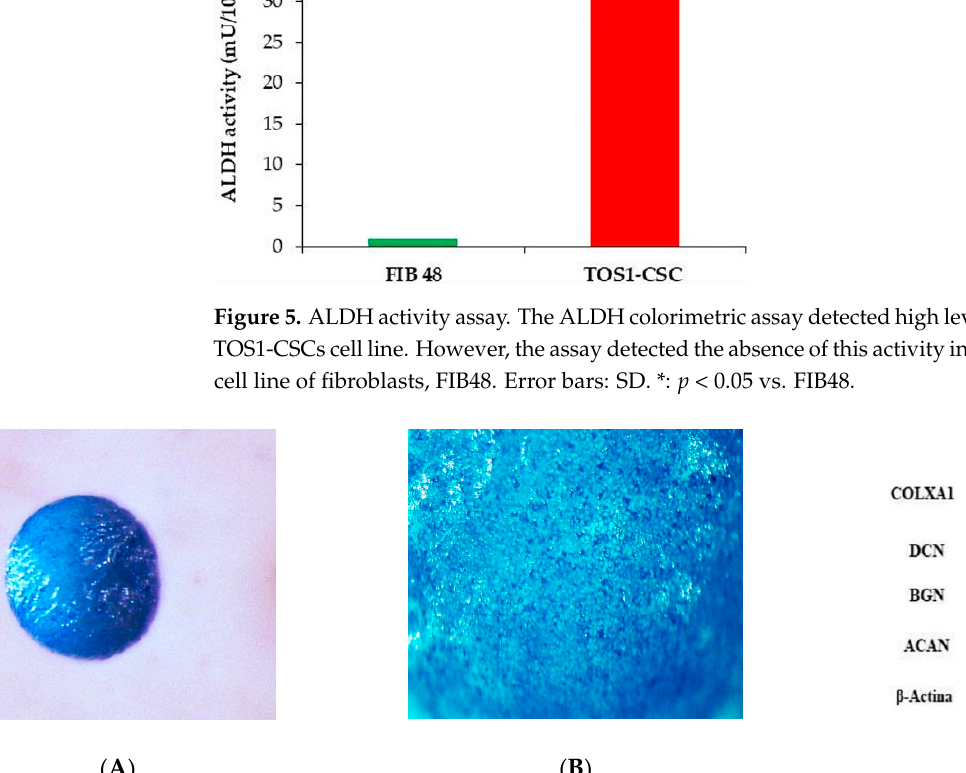
Figure 5. ALDH activity assay. The ALDH colorimetric assay detected high levels of ALDH activ- ity in TOS1-CSCs cell line. However, the assay detected the absence of this activity in the finite